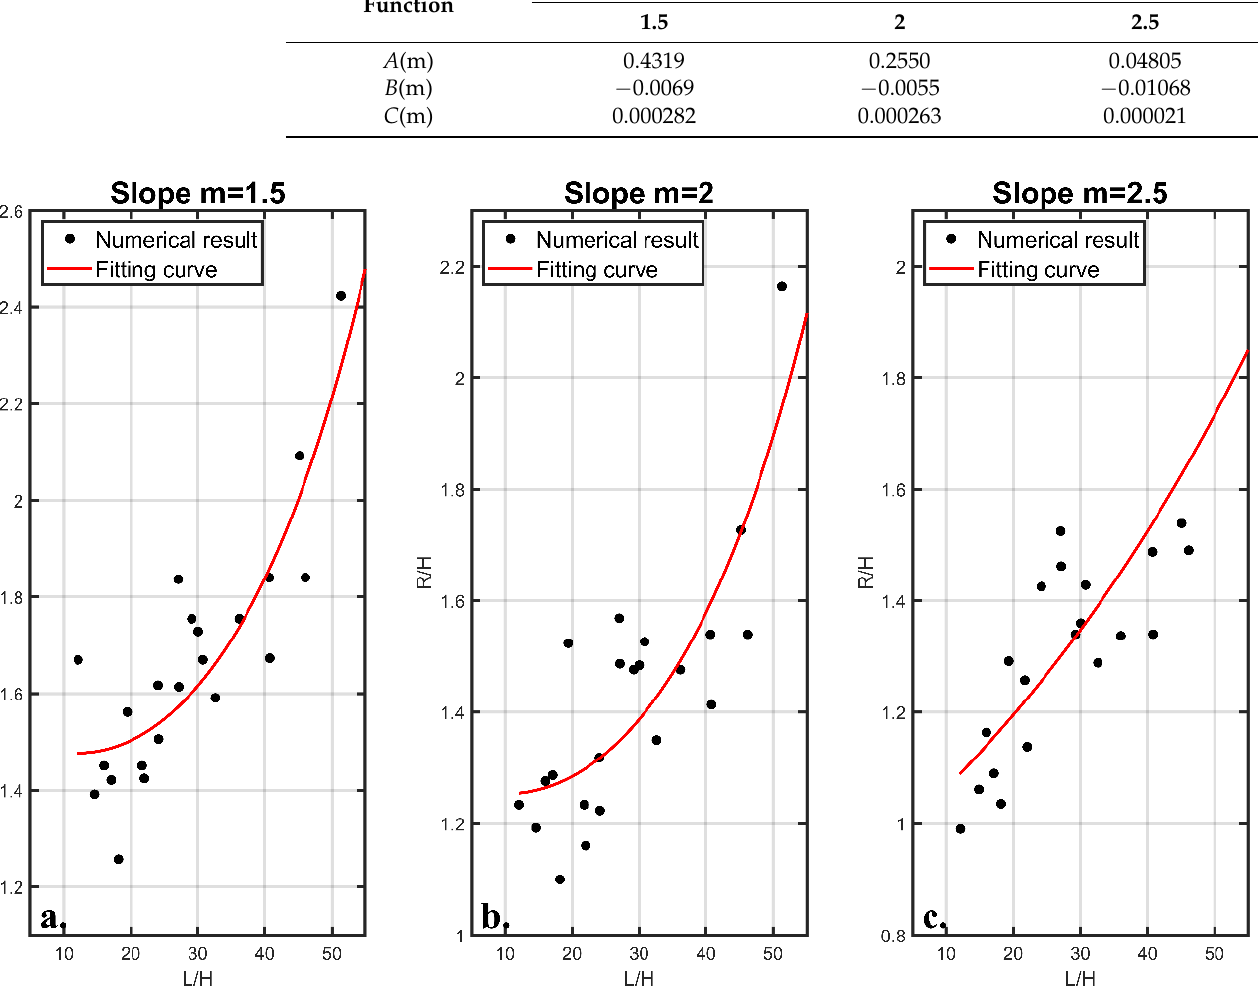
Figure 16. Fitting line for m = 1.5 ( a ); m = 2.0 ( b ); m = 2.5 ( c ) from the numerical model results.